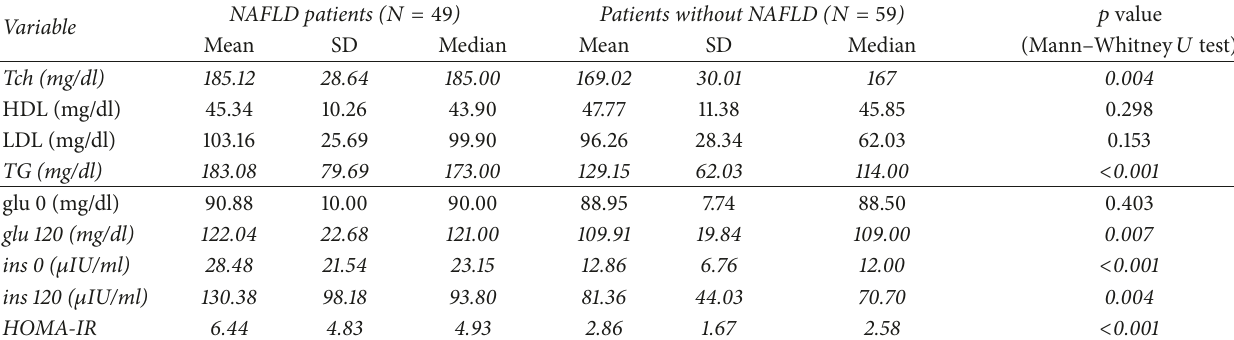
Table 3: Biochemical analysis. Comparison of patients with and without